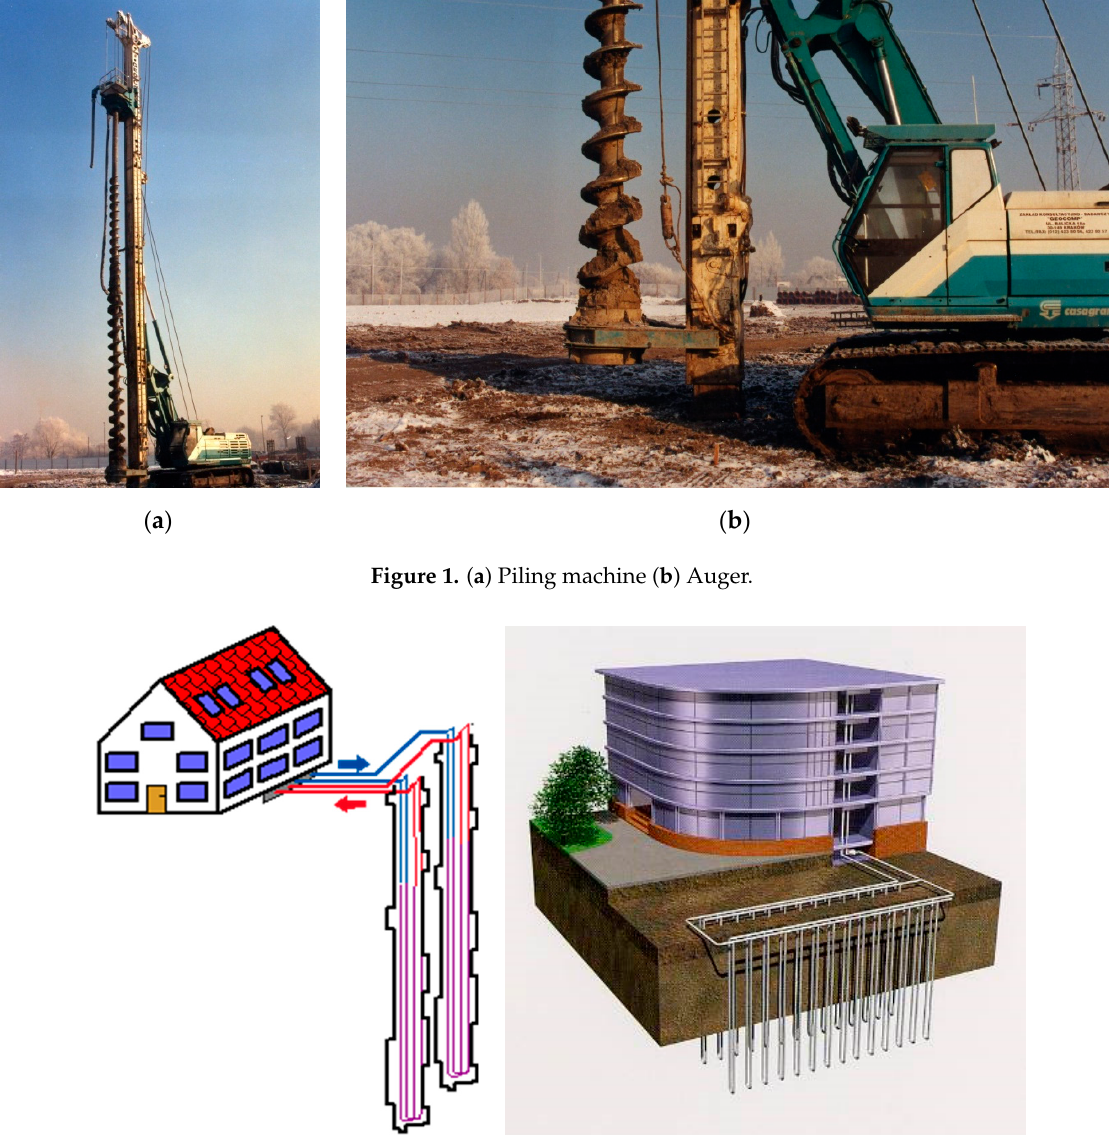
Figure 1. ( a ) Piling machine ( b ) Auger.